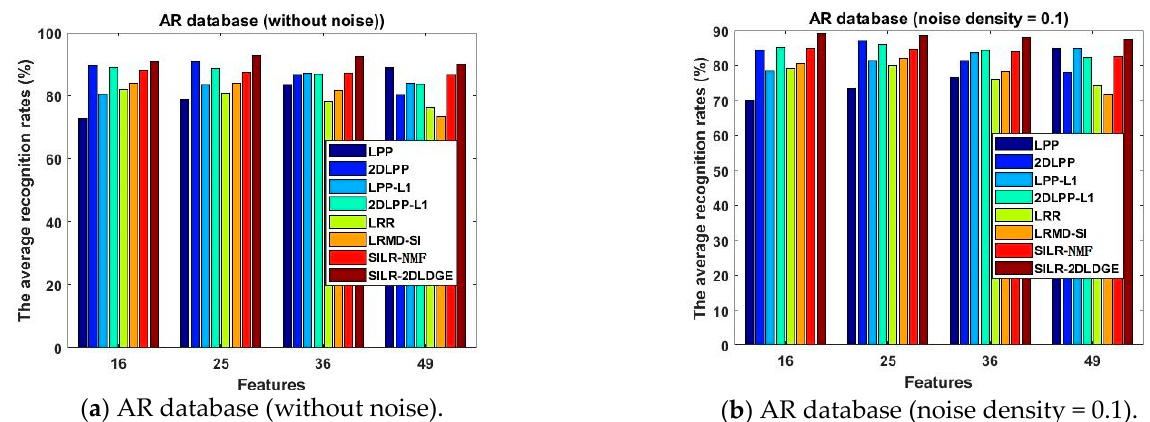
Figure 8. The average recognition rates (%) of the eight algorithms in the AR database vary with the dimension.